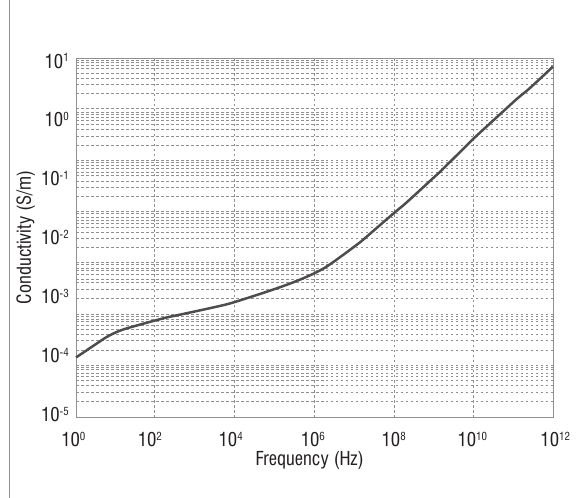
Figure 1: Longmire’s 5 universal curve for dielectric constant ( ε function of frequency for a 10% moisture content.